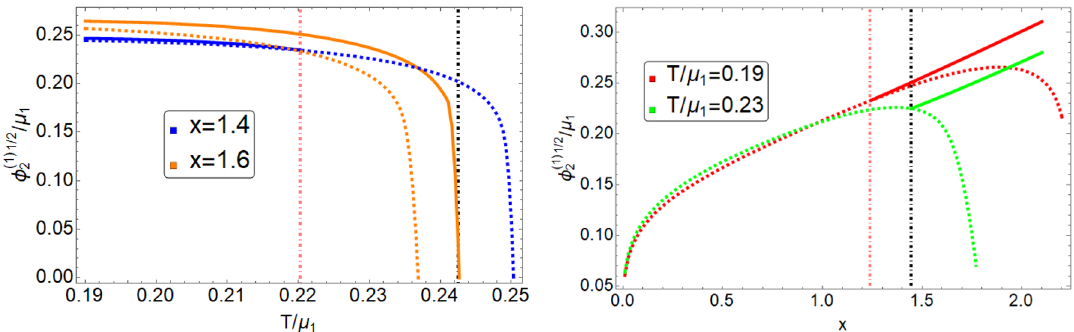
Figure 14 . The CDW order parameter φ (1) as the function of temperature T (left) and doping pa- 2 rameter x(right). The solid lines in color stand for φ (1) in SSC phase, while the dashed lines in color 2 stand for φ (1) in the absence of SC. The vertical lines denote the location of SSC phase transition. 2